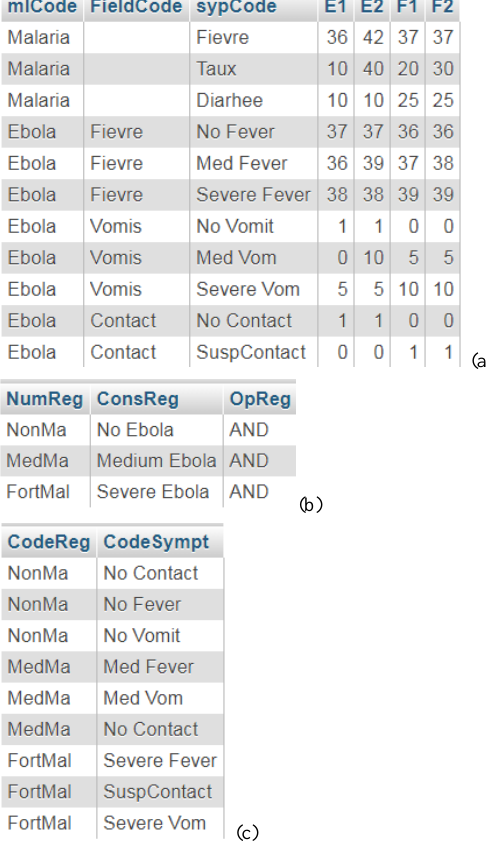
Fig. 4. Rule base